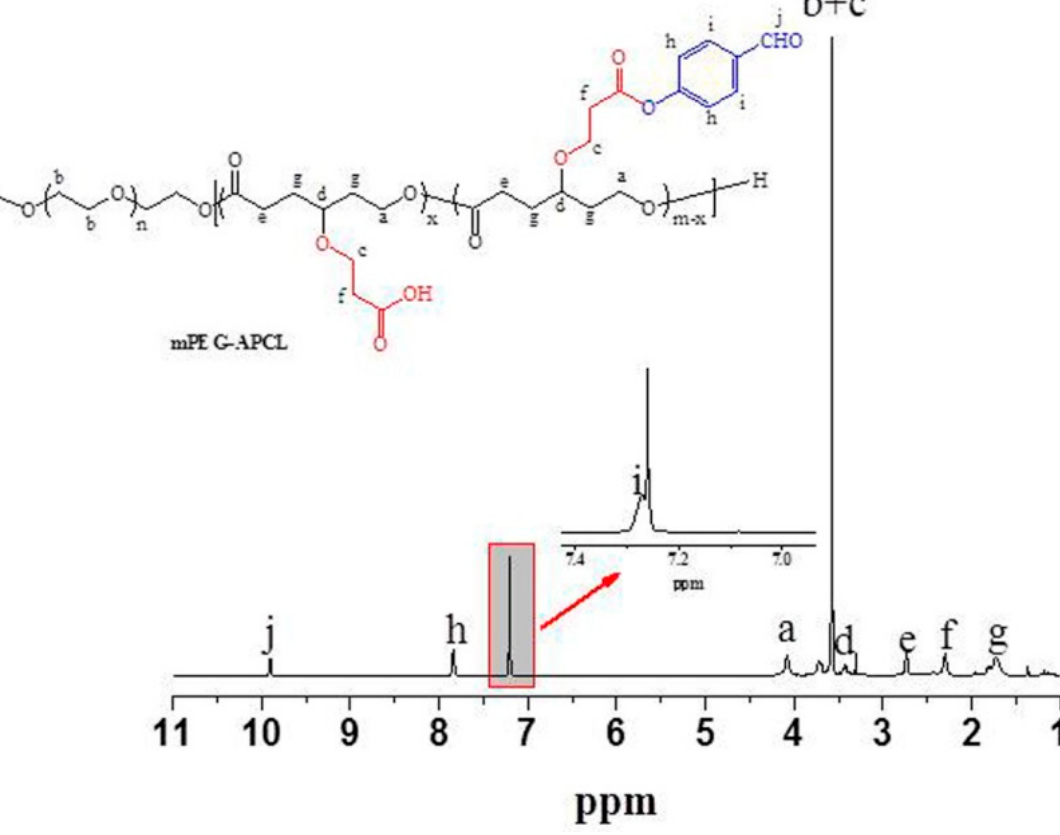
Figure 2. 1 H NMR spectrum of mPEG-APCL.